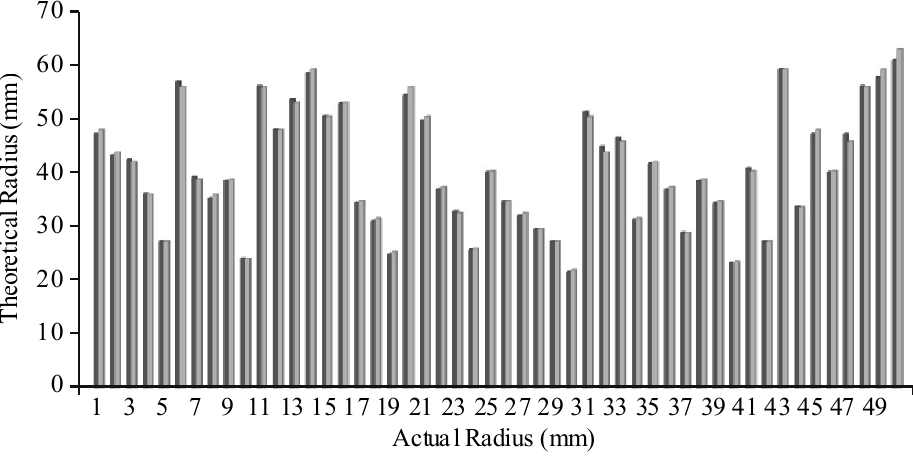
FIG. 7. COLUMN CHART BETWEEN ACTUAL AND THEORETICAL RADII FOR CYLINDERS OF THE SUBJECTS TABLE 3. REGRESSION LINE No.